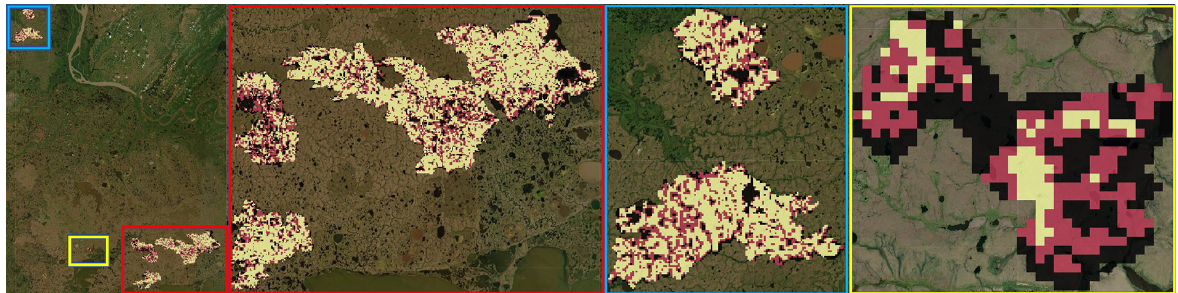
Figure A5. Fire severity across the YKD 2015 fire area categorized using dNBR values into low-severity/unburned (black), moderate- severity (red), and high-severity (yellow) categories. The panels show the total fire area (far left), then close-ups of the southeastern (red), northwestern (blue), and south-central (yellow) fire scars, respectively. Basemap sources: Esri, DigitalGlobe, GeoEye, i-cubed, USDA FSA, USGS, AEX, Getmapping, Aerogrid, IGN, IGP, swisstopo, and the GIS user community.